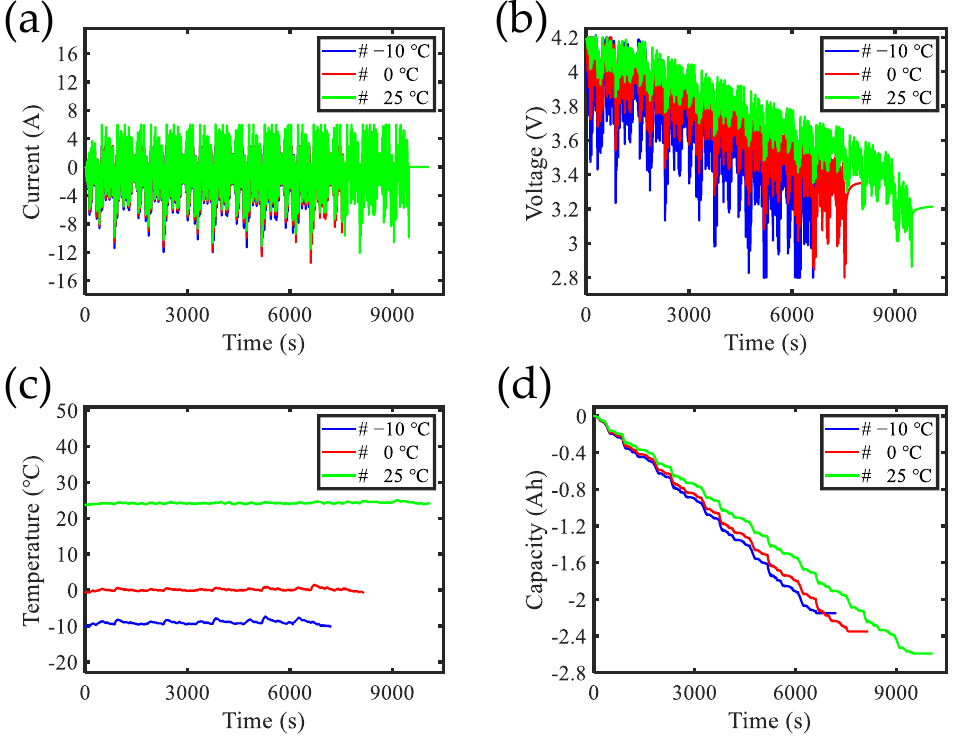
Figure 3. Test data of LA92 at three temperatures ( − 10, 0, and 25 ◦ C); ( a ) current ( b ) voltage ( c ) temperature ( d ) discharge